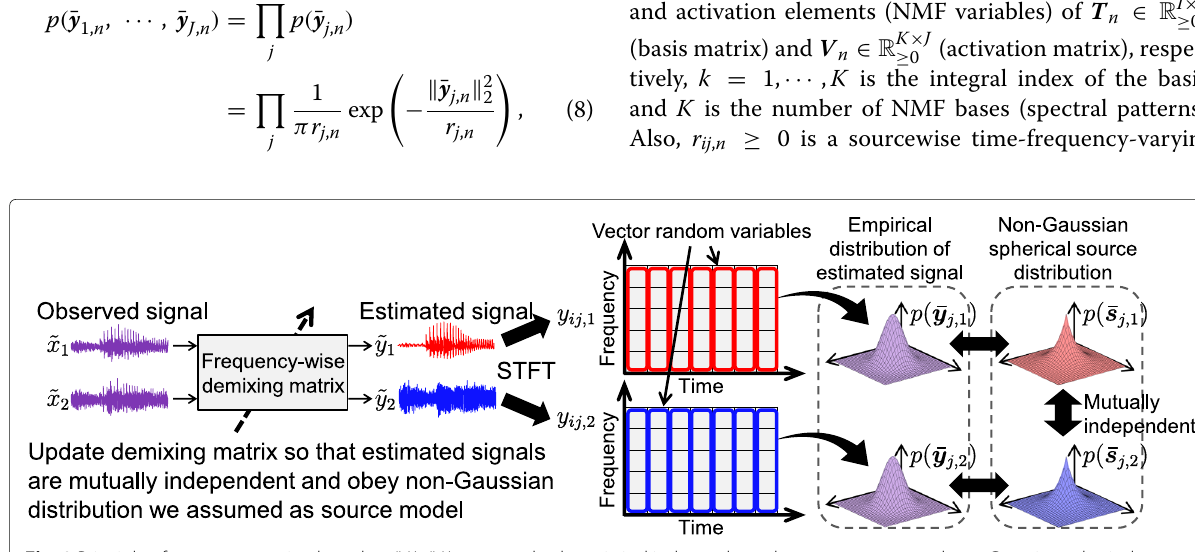
Fig. 2 Principle of source separation based on IVA. IVA assumes both statistical independence between sources and non-Gaussian spherical distribution for vector